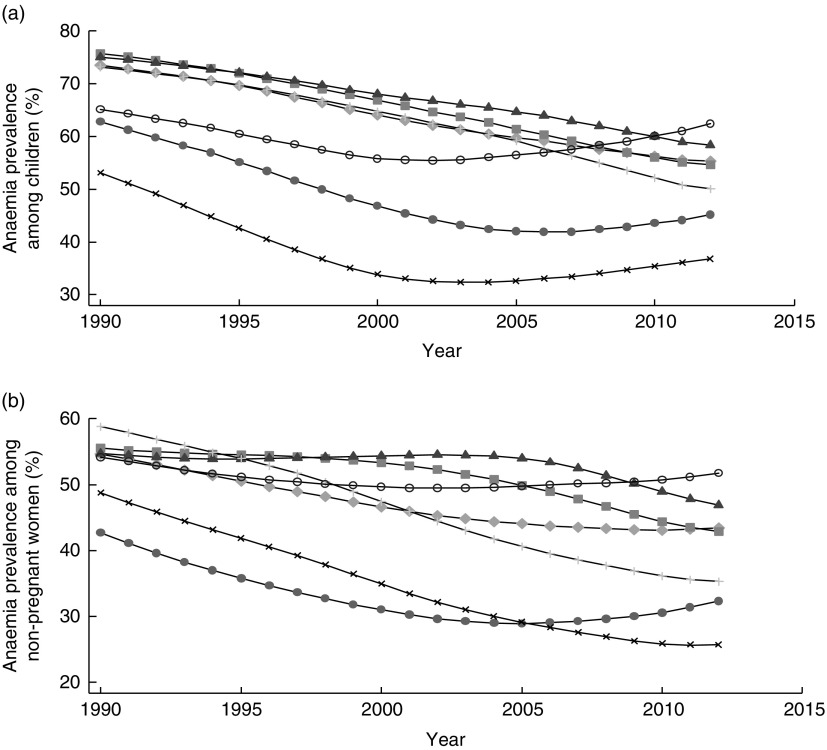
Prevalence of anaemia across time (1990–2012) among (a) children 6–59 months old
and (b) women of reproductive age in South Asia, by country: ,
Afghanistan; , Bangladesh; ,
Bhutan; , India; ,
Nepal; , Pakistan; ,
Sri Lanka. (Data from Stevens et al.(

3

))